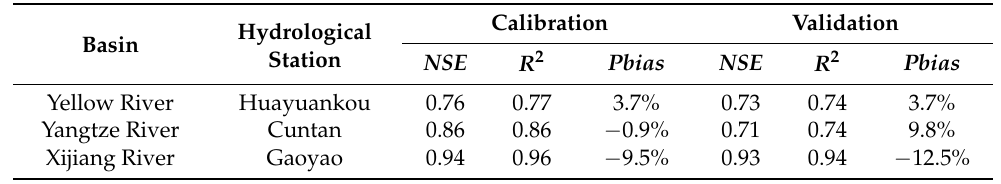
Table 1. Performance of hydrologiska byråns vattenbalansavdelning (HBV) simulations for the monthly streamflow in the study areas.